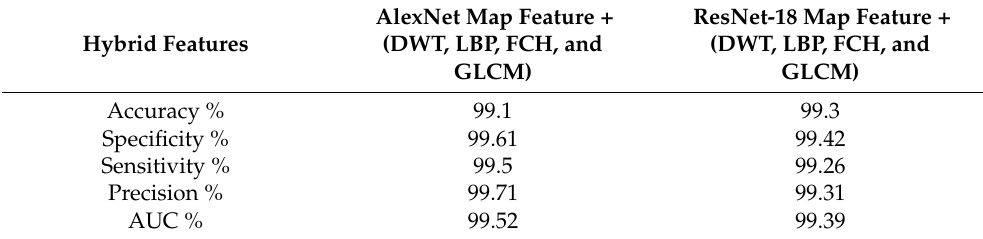
Table 4. Performance of ANN based on fusion features for early diagnosis of OSCC.